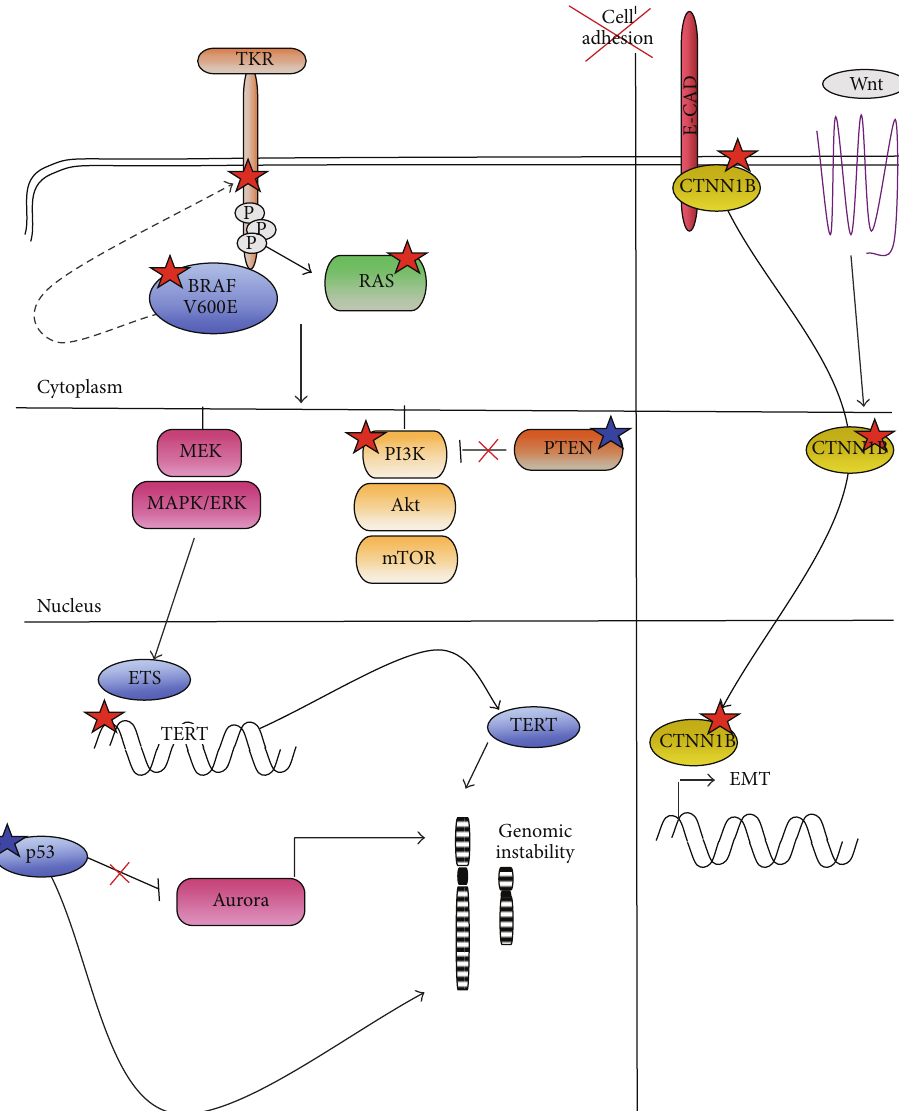
Figure 8: Schematic representation of molecular pathways altered in